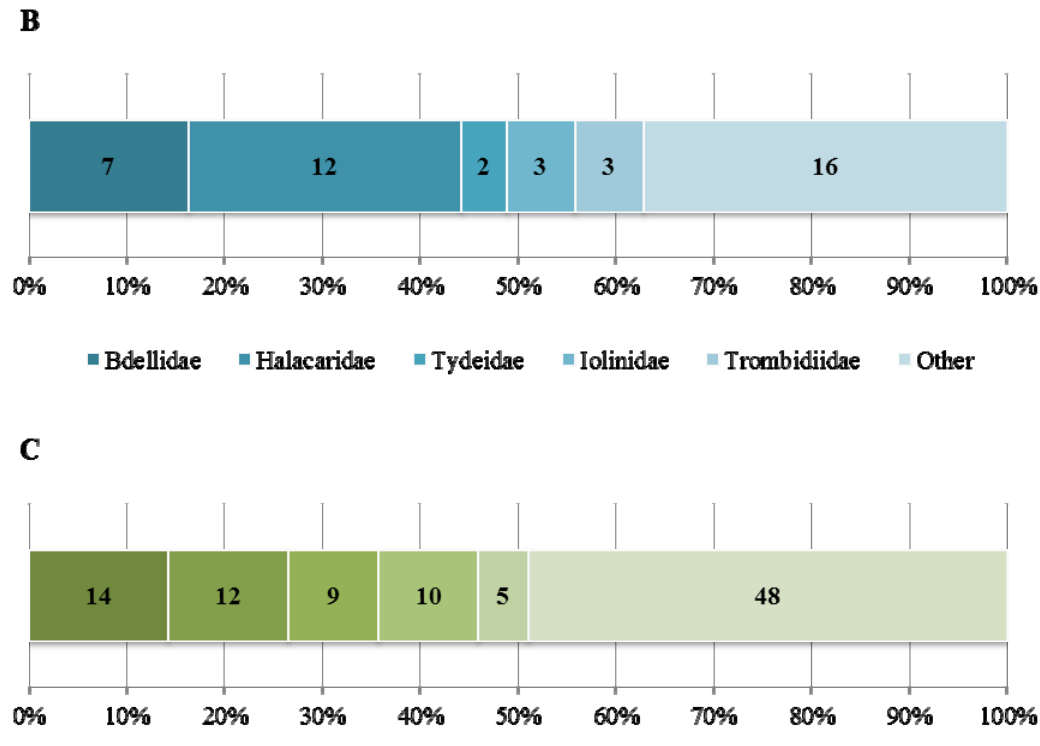
Figure 2. Diversity of the mite families in Svalbard: ( A ) Mesostigmata; ( B ) Trombidiformes; ( C ) Sarcoptiformes. The number of species occurring in Svalbard is presented on bars. No figure was made for the Ixodida, which is represented in Svalbard by one family only.